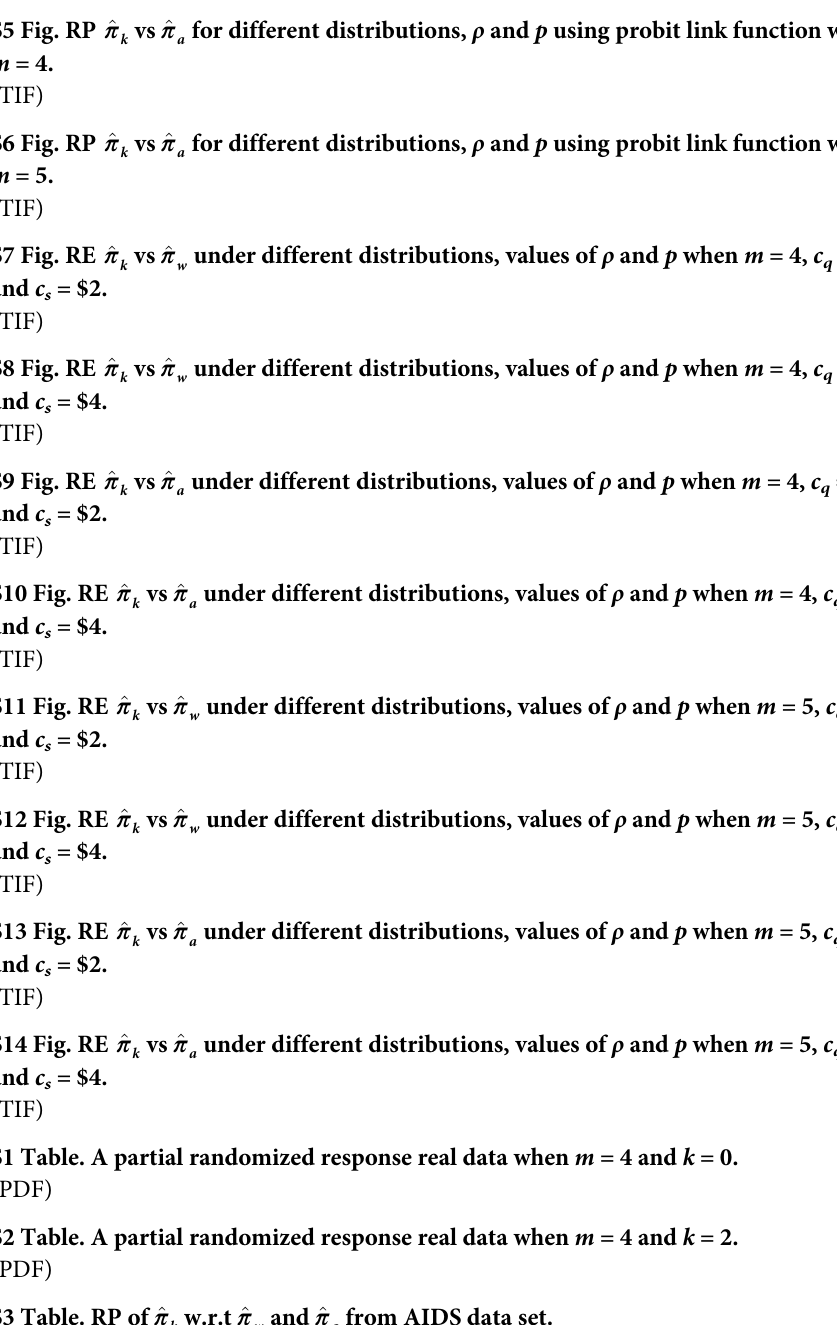
= $20 q = $20 q = $20 q = $20 q